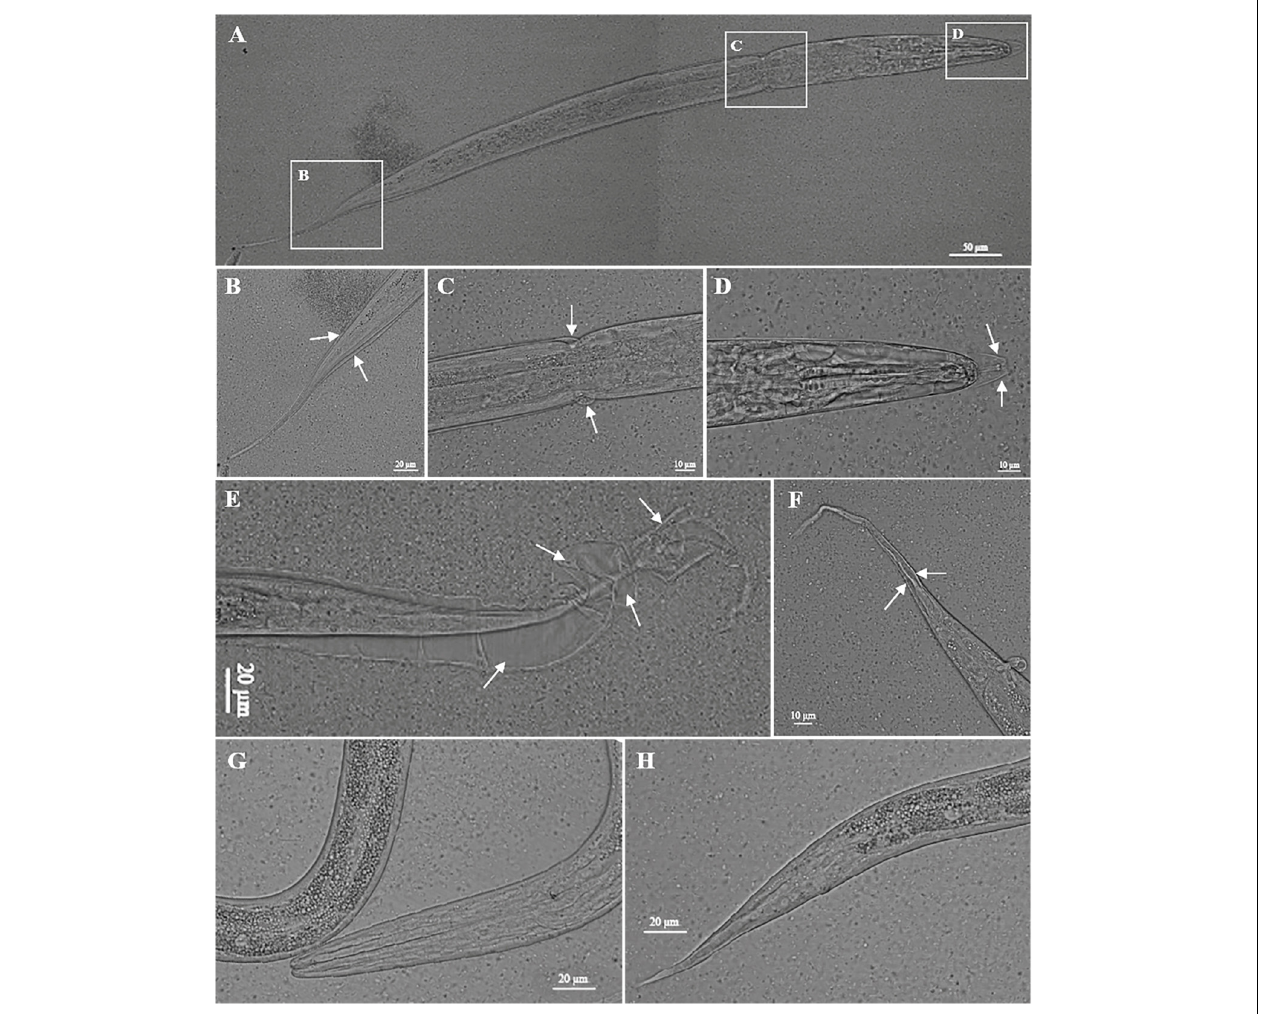
FIGURE 3 | Knockdown of nas-33 leads to molting defects in Haemonchus contortus . (A–D) Defects in the first molting of H. contortus led to larva death. (E,F) Defects in the first molting of H. contortus resulted in attachment of the old cuticle to the second stage larva. Cuticles failed to be shed are marked with white arrows. (G,H) Phenotype of untreated larvae of H. contortus .